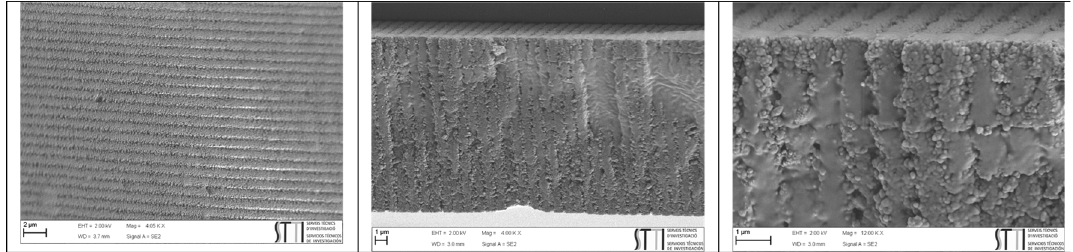
Figure 7. High-resolution SEM images for a sample of HPDLC with peppermint oil (purity 50%). Center and right images are taken by cross-sectional viewpoint.